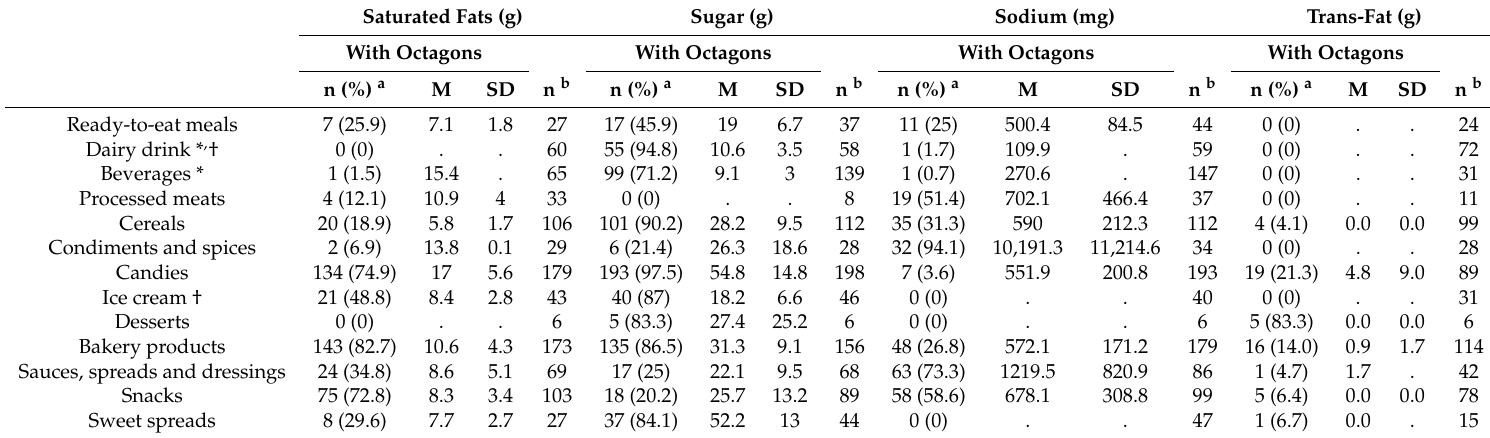
Table 4. Percentage of foods by category that would carry front-of-package warning labels 39 months after implementation of the